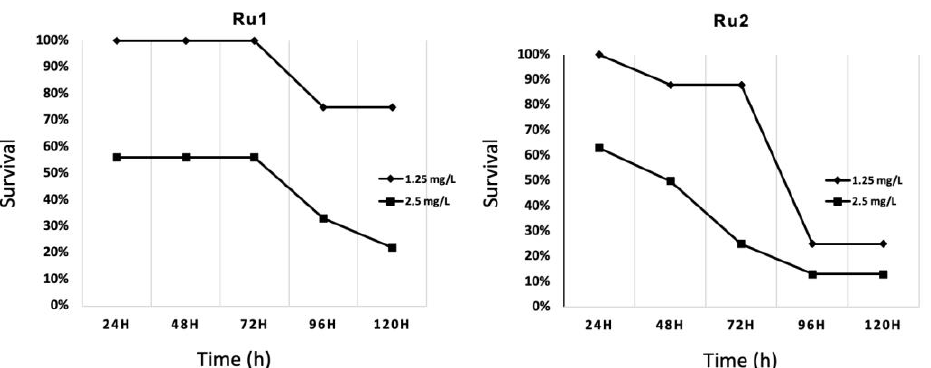
Figure 7. Survival evolution through time of 24 h post fertilization (hpf) zebrafish embryos exposed to ruthenium compounds at different concentrations; higher concentrations (5.0 and 10.0 mg·L −1 ) showed no survival at 24 h post treatment (hpt).